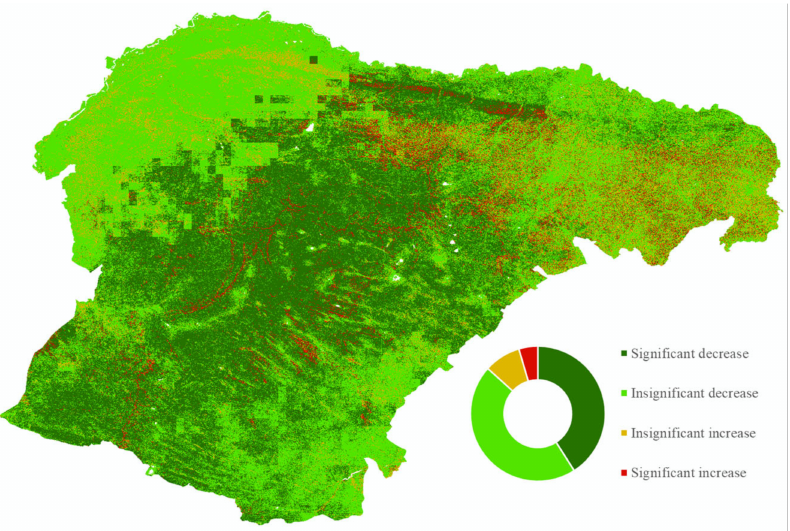
Figure 6. Trend change of soil erosion from 2013 to